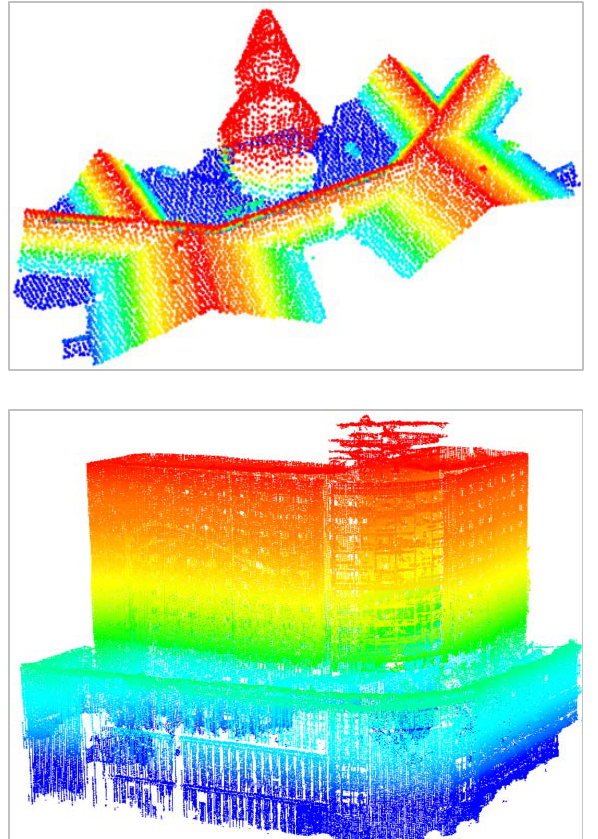
Figure.1. Overview of the tested data . Top: the ALS point cloud (S1). Bottom: Merged MVS and TLS point data (S2).